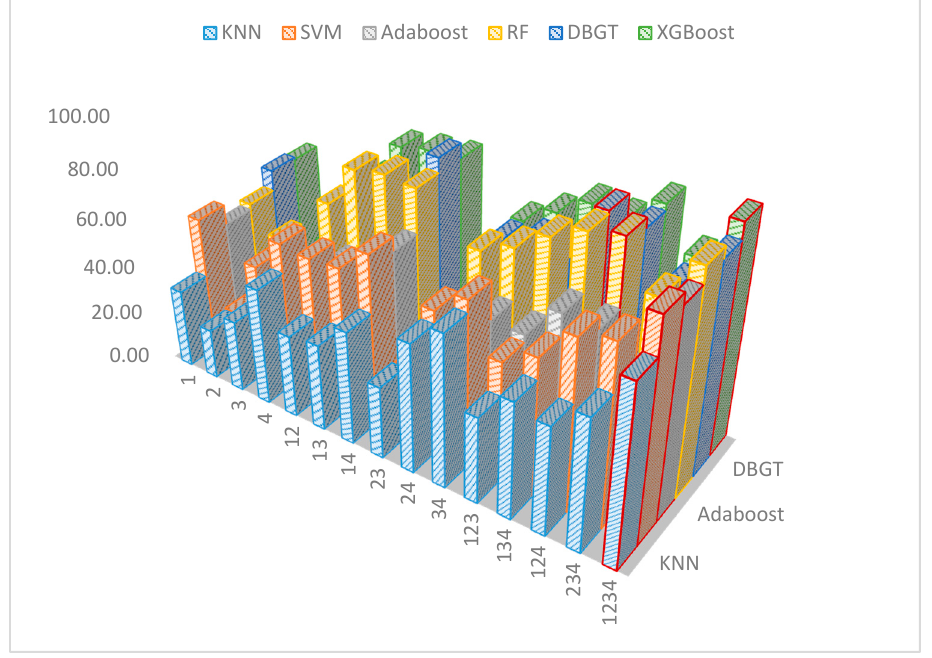
Figure 15. Comparison of Features and Classifiers by ACC. Table 17. Impacts of Features and Classifiers on